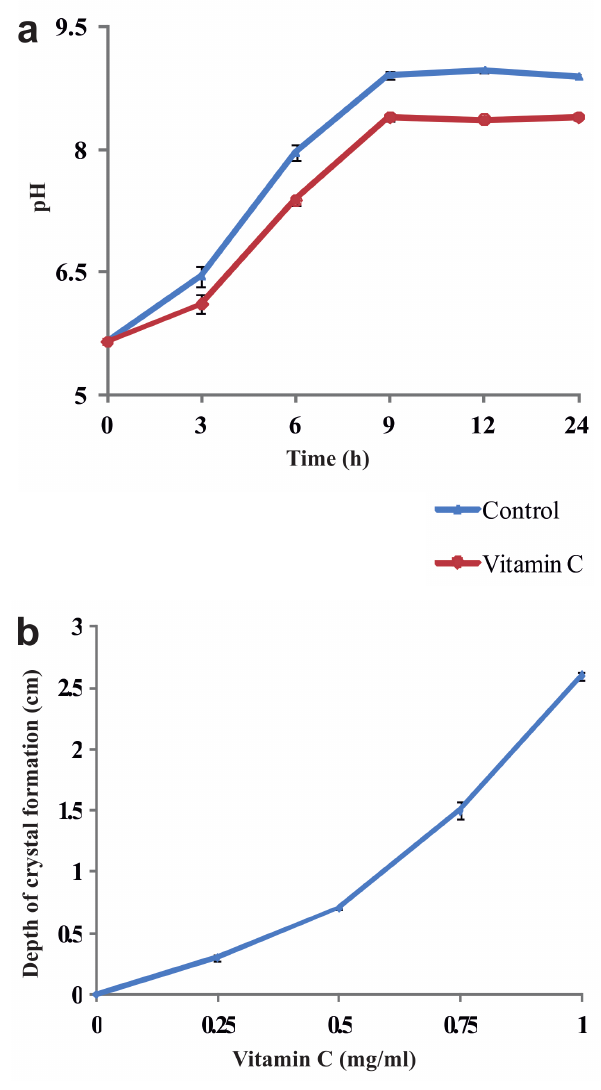
Figure 2 - Photograph of the struvite crystals grown in gel medium in artifi cial urine infected with Pseudomonas aeruginosa and treated with different concentrations of vitamin C at different time points (0th, 1st, 7th and 15th day). (a) In the absence of vitamin C (b & c) In the presence of 0.5 mg/mL and 1 mg/mL vitamin C respectively.